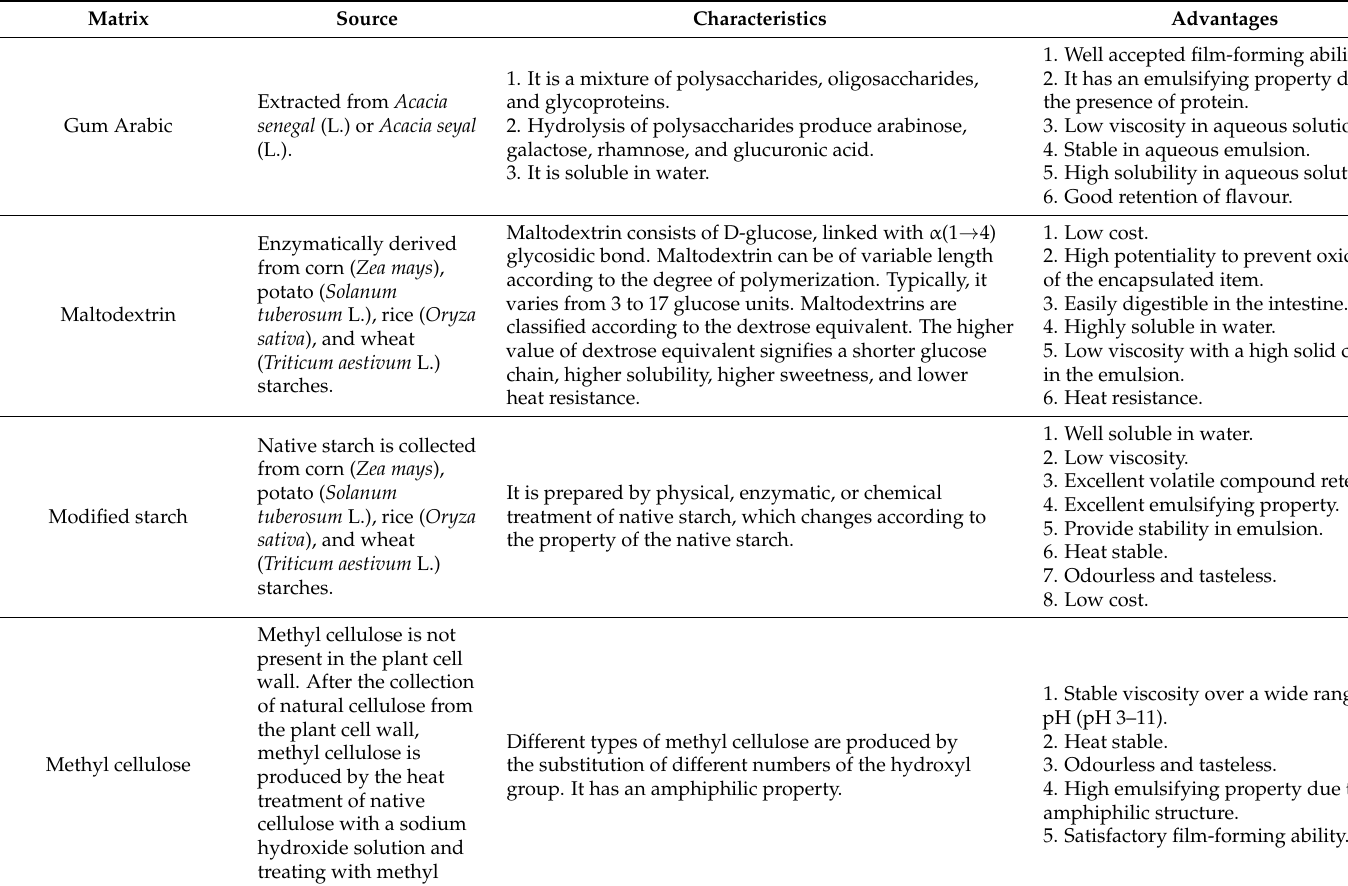
Table 2. Characteristics of the matrix used for the microencapsulation of flaxseed